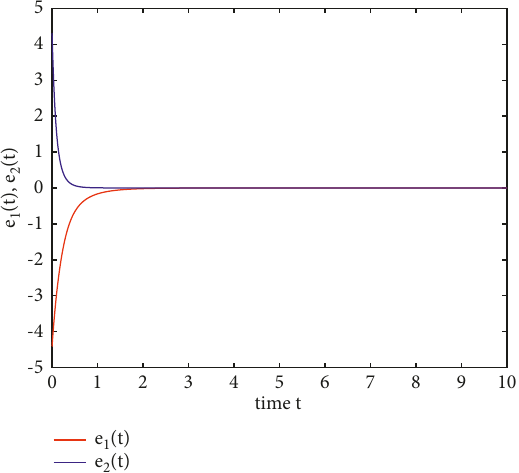
Figure 12: Trajectories of e under controller